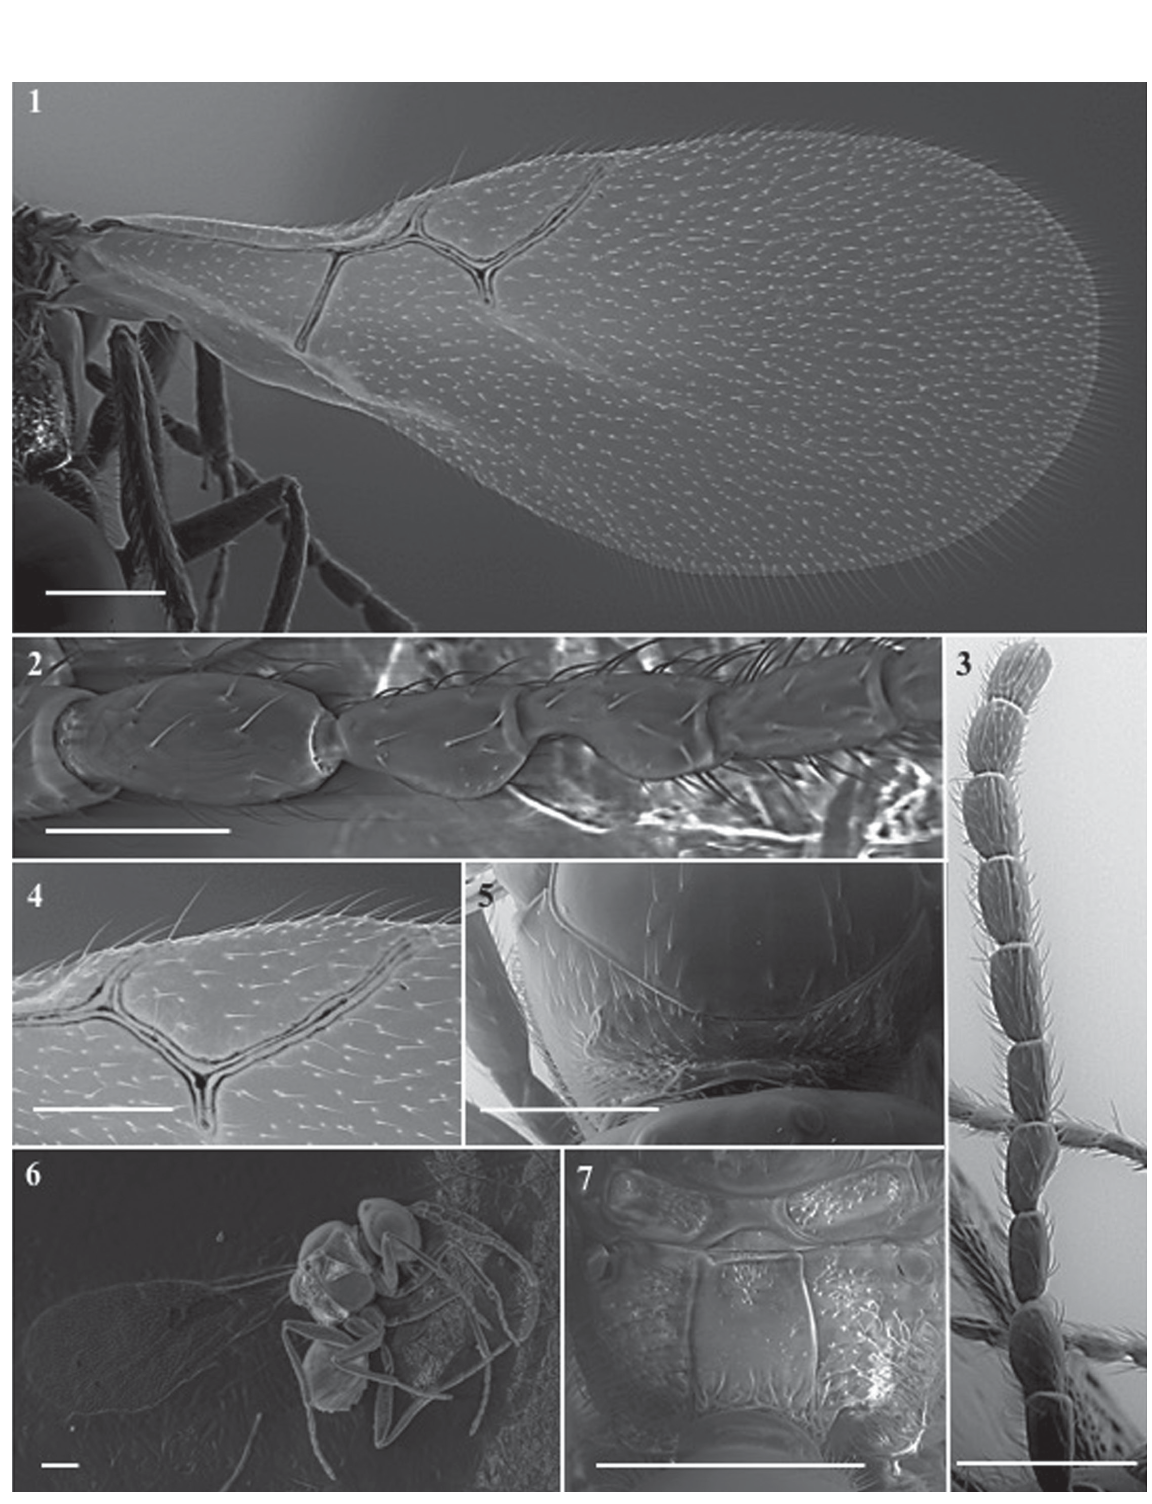
Fig. 12. Alloxysta palearctica Ferrer-Suay & Pujade-Villar sp. nov. 1 . Fore wing. 2 . Detail of antenna. 3 . Antenna. 4 . Radial cell. 5 . Pronotum. 6 . Body. 7 . Propodeum. Scale bars: 50